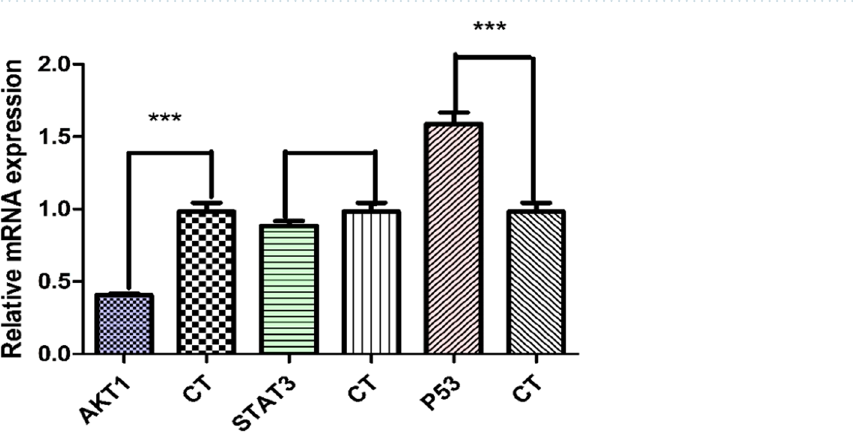
Figure 9. The mRNA expression levels of AKT1, STAT3, P53. Compared with the control group, the expression levels of AKT1 and P53 mRNA have significant difference in the treatment group (***p <